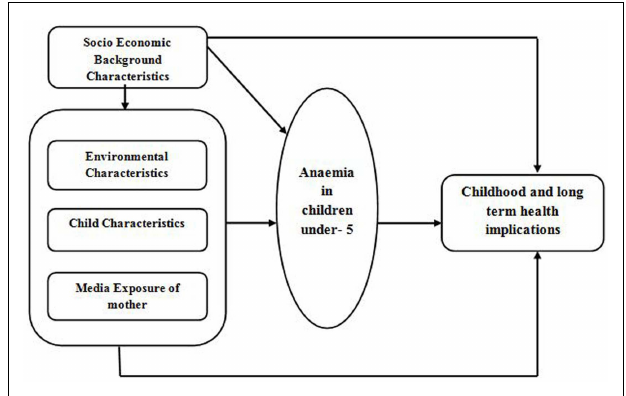
FIGURE 1 | Conceptual framework for the study